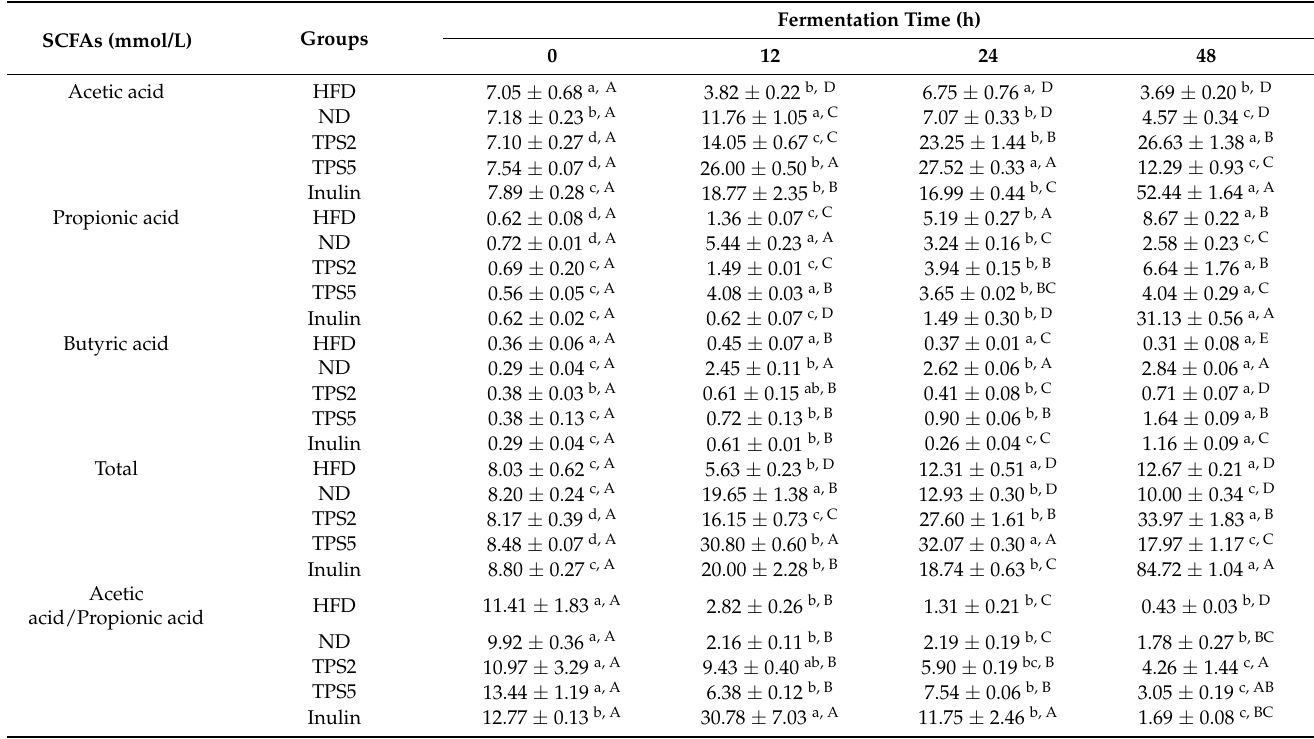
Table 4. Short-chain fatty acids and ratio of acetic acid to propionic acid at different time points of